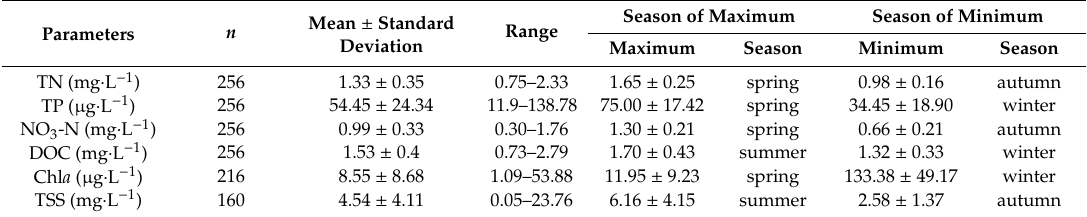
Table 1. Summary of the program water quality parameters in the Jiekou Monitoring Station.